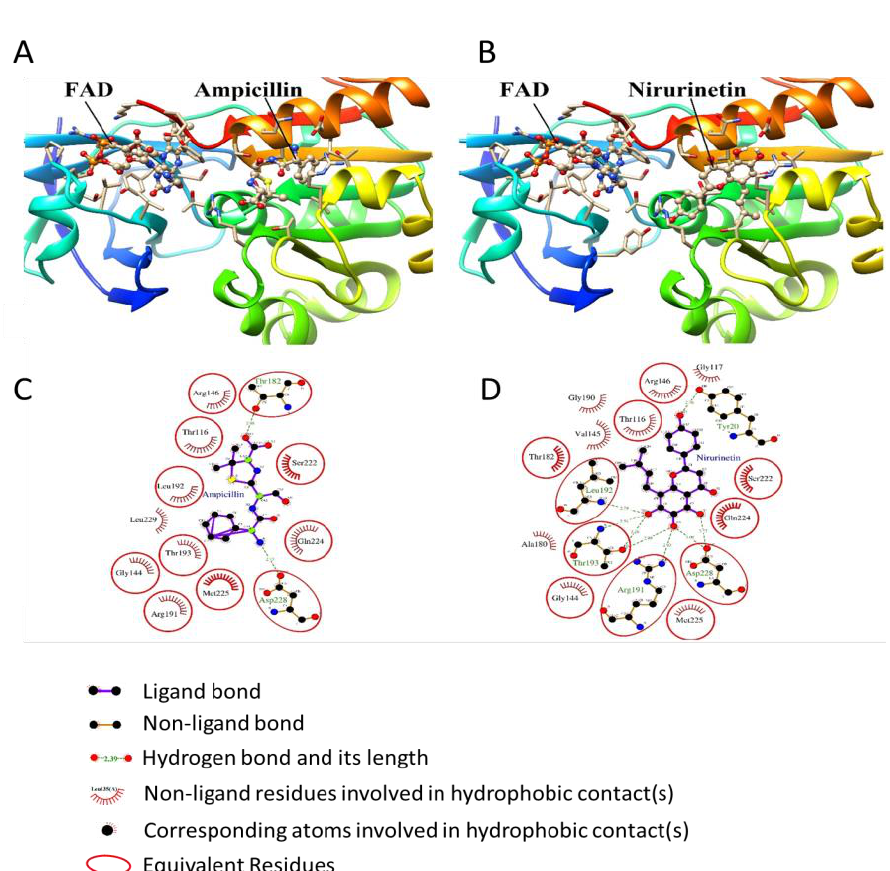
Figure 4. Molecular docking analysis of ampicillin and nirurinetin with FAD-containing ferredoxin-